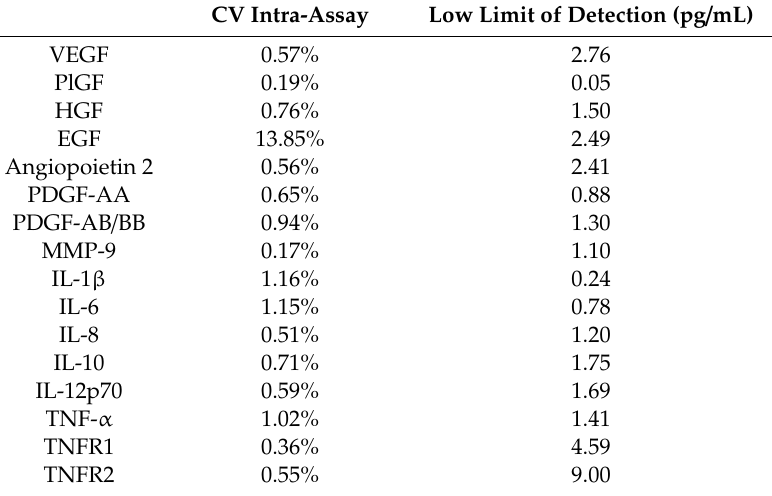
Table 1. Coe ffi cient of intra-assay variation and lower detection limits. CV Intra-Assay Low Limit of Detection (pg /